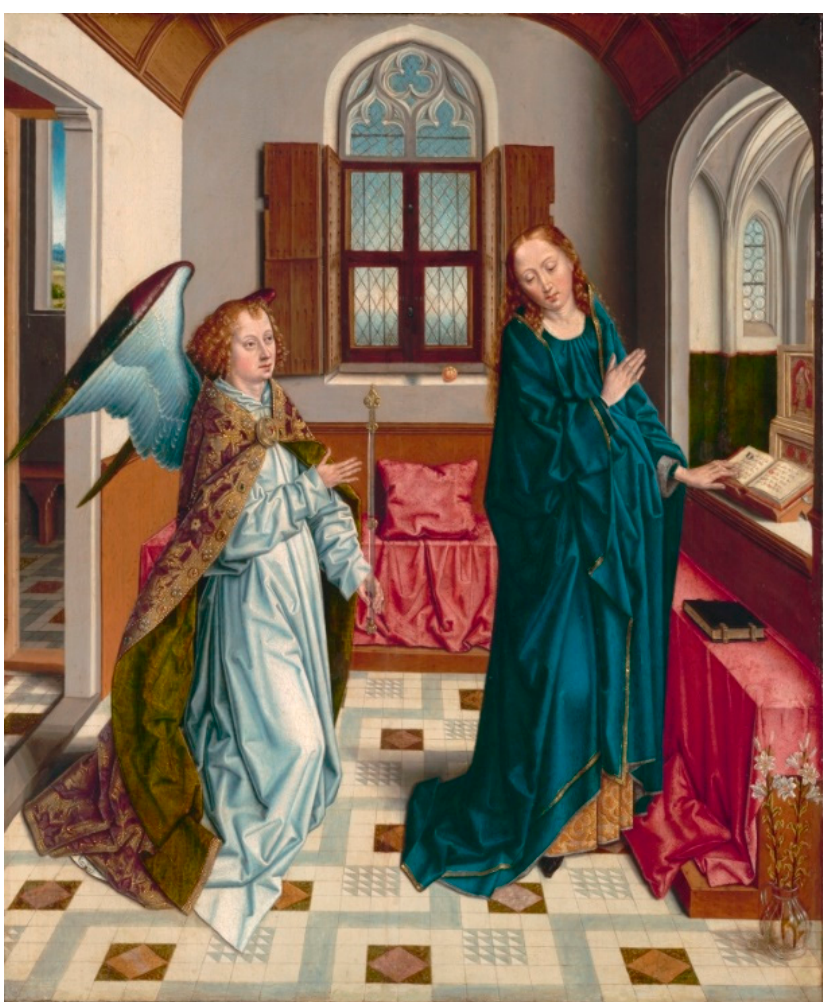
Figure 13. Aelbrecht Bouts, The Annunciation , c. 1480. The Cleveland Museum of Art,